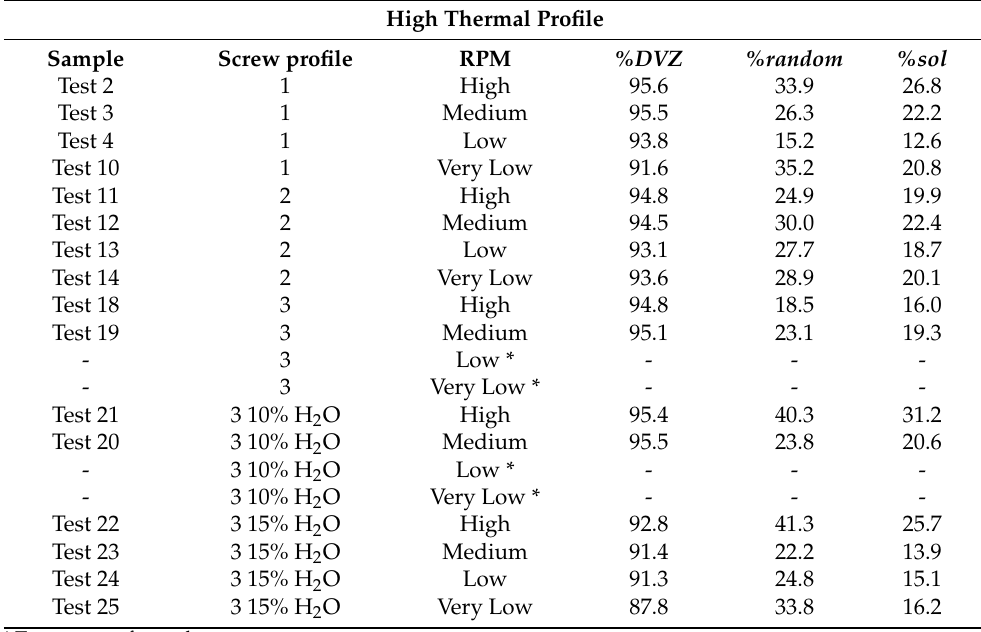
Table 3. %DVZ, %random and %sol for devulcanization carried out at high thermal profile. High Thermal